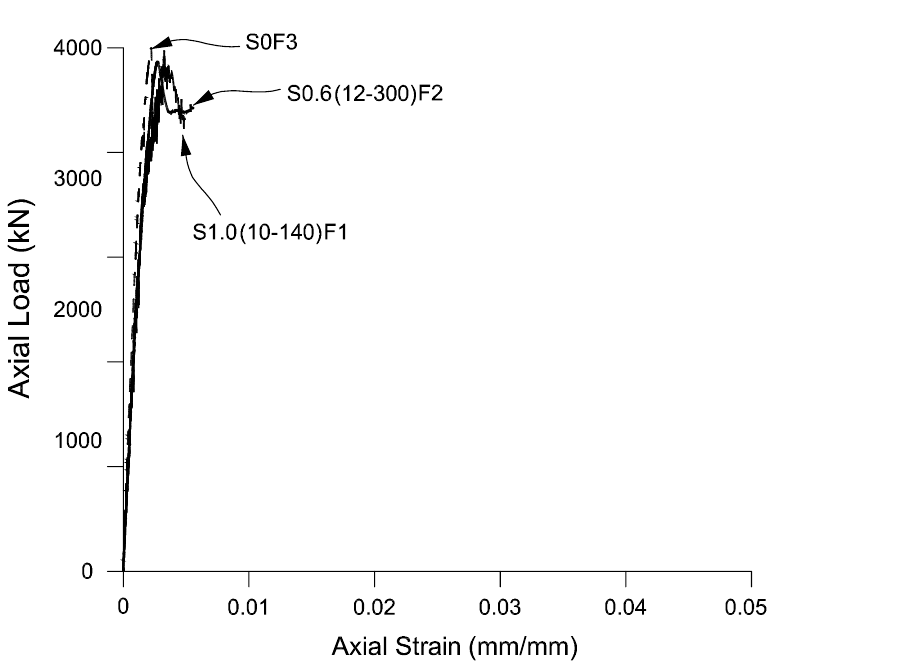
Figure 5. Axial load versus axial strain of FRP-TSR confined